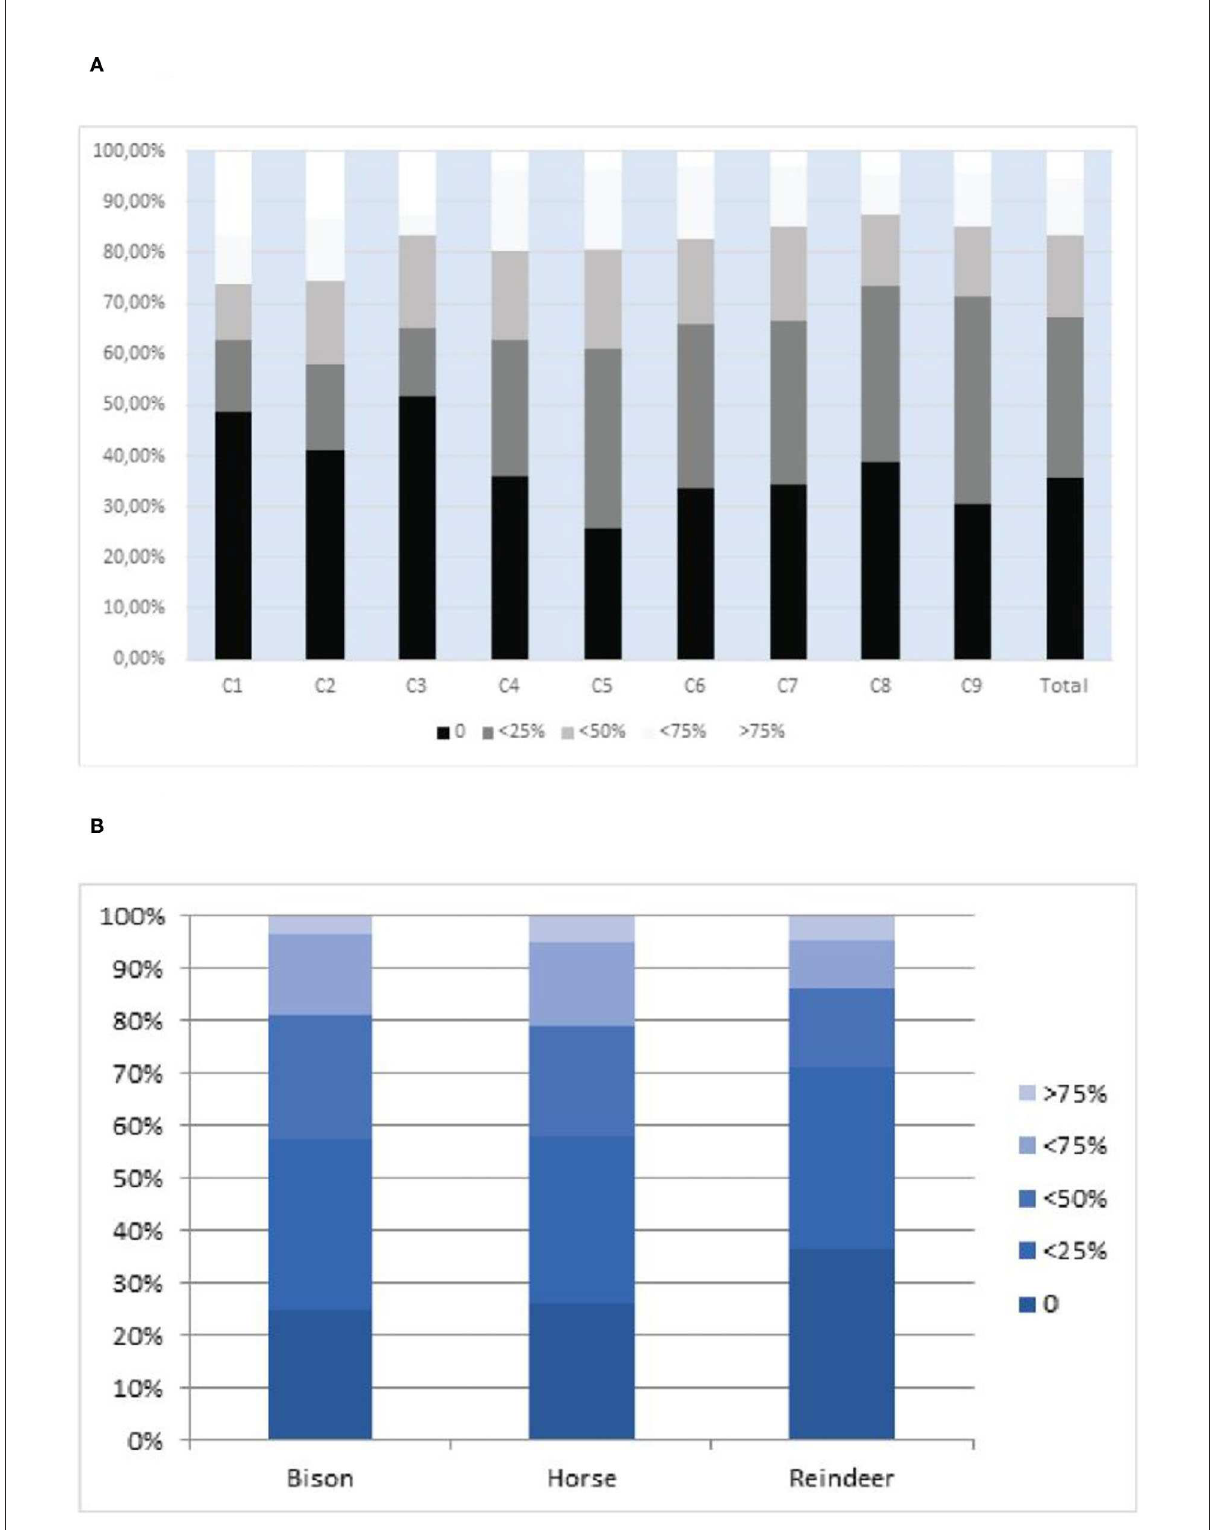
FIGURE5 (A) Preservation of the cortical surfaces (per quartile) following (Rendu, 2010; Rendu et al., 2019): Stage 0: no destruction; Stage1: < 25% destroyed; stage2: < 50%; stage 3: < 75%; Stage 4: > 75% destroyed. (B) Preservation of the cortical surfaces for the three main taxa, (per quartile) following (Rendu, 2010; Rendu et al., 2019) (Stage 0: no destruction; Stage1: < 25% destroyed; stage2: < 50%; stage 3: < 75%; Stage 4: > 75%